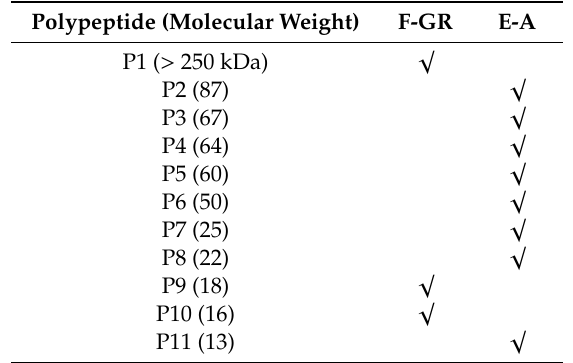
Figure 1. Polypeptides detected in seeds and juice from two pomegrante Spanish populations. SDS-PAGE was run on 12% acrylamide gels, and polypeptides were detected by silver staining. Two pomegranate populations from Spain were studied: from El Fargue, Granada (F-GR) and Elche, Alicante (E-A). Di ff erentially abundant polypeptides are labelled (P1-P12). For seed samples, 13.8 of µ g protein was loaded. For juice samples, 25 µ l were directly used after incubating with sample bu ff er. Molecular markers are displayed on the left. Table 1. Polypeptides detected by SDS-PAGE showing di ff erential abundance in seeds from two pomegranate Spanish populations. Pomegranate fruits were collected from El Fargue, Granada (F-GR) and Elche, Alicante (E-A). The polypeptide molecular weights are displayed in parentheses. Marks show where polypeptides were more